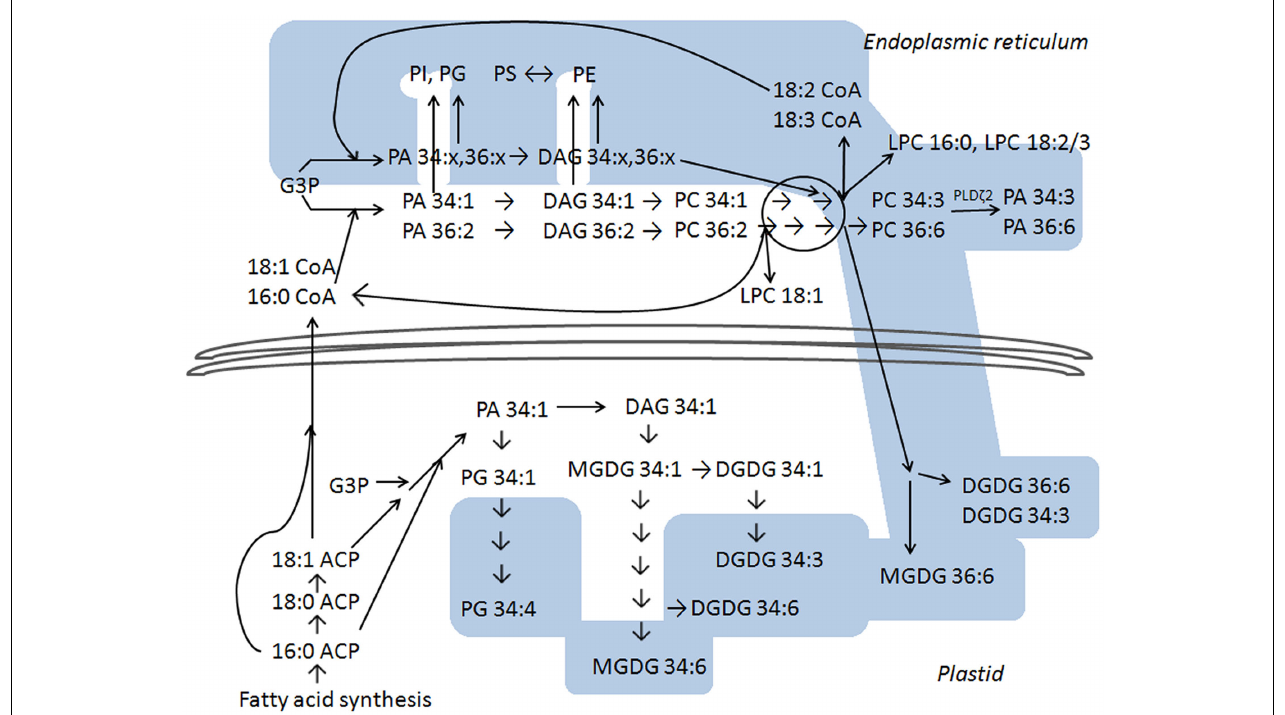
place outside the plastid (in the endoplasmic reticulum). PC hydrolysis by PLD is depicted on the upper right; among PLD gene products tested, PLD ζ 2 is most clearly implicated in formation of PA in the dark. No attempt is made to suggest specific details as to location within the plastidic or extraplastidic (endoplasmic reticulum) sites. Details are discussed in the text. Abbreviations not defined elsewhere include: ACP for acyl carrier protein, CoA for Coenzyme A, DAG for diacylglycerol, and G3P for